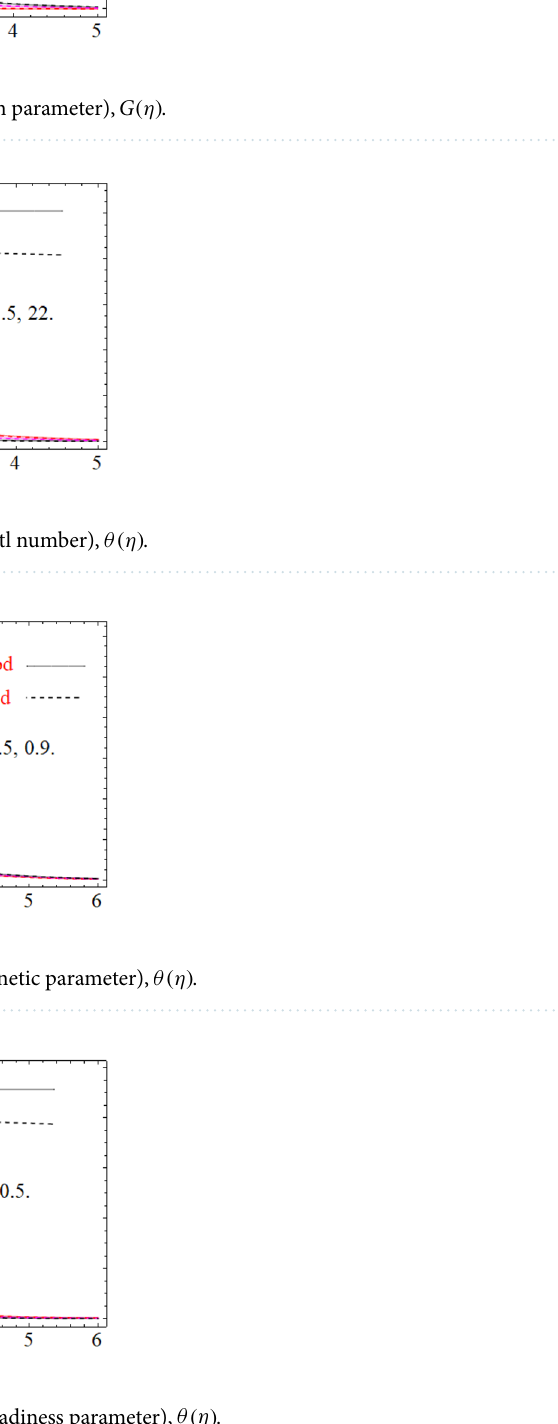
Figure 11. Under the influence of A (unsteadiness parameter), θ(η)